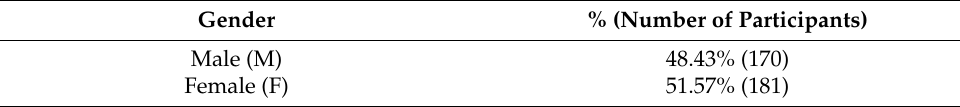
Table 15. Gender.